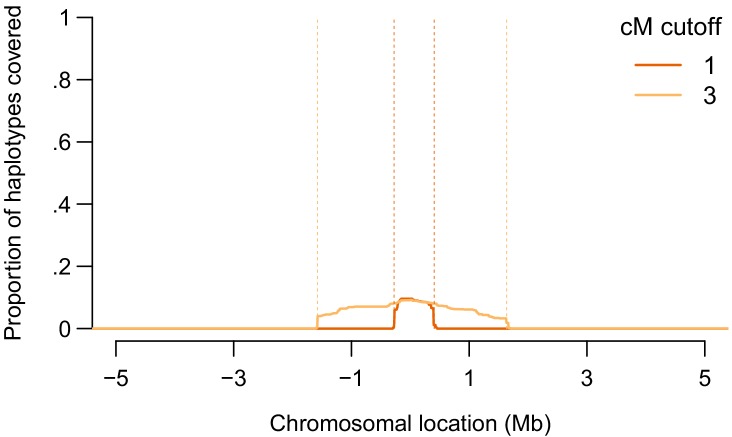
IBS probing using Germline (Gusev et al., 2009) in haploid mode.A demonstration of the IBS probing method around position 45411941 on chromosome 19 (GRCh37 coordinates), in the APOE locus. Conventions are the same as in Figure 3; the difference is that IBS calling was performed by Germline (Gusev et al., 2009) in haploid mode, meaning that phasing switches are disallowed. We set the err_hom argument to zero, we used the w_extend flag to extend segments beyond the slices produced by Germline, and we set the minimum IBS segment length to 1-cM. All other arguments were kept at their default values. When IBS probing is performed with a 1-cM threshold, 67.5% of haplotypes had a match among the probes constructed from the other 871 people in the dataset. With a 3 cM threshold, 0.2% of haplotypes had a match.